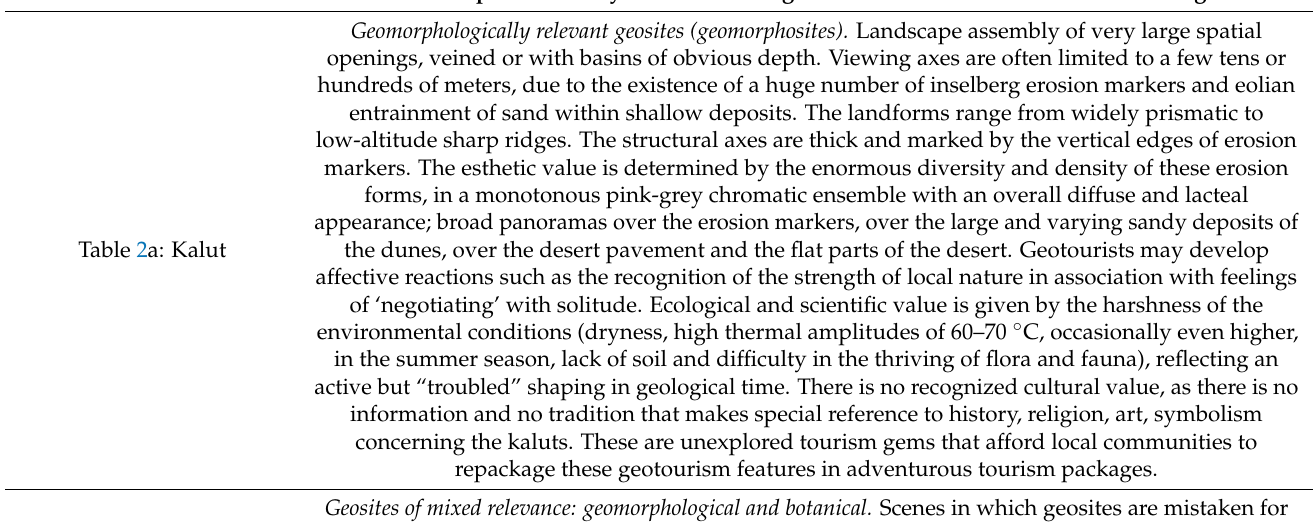
Geosites of mixed relevance: geomorphological and botanical. Scenes in which geosites are mistaken